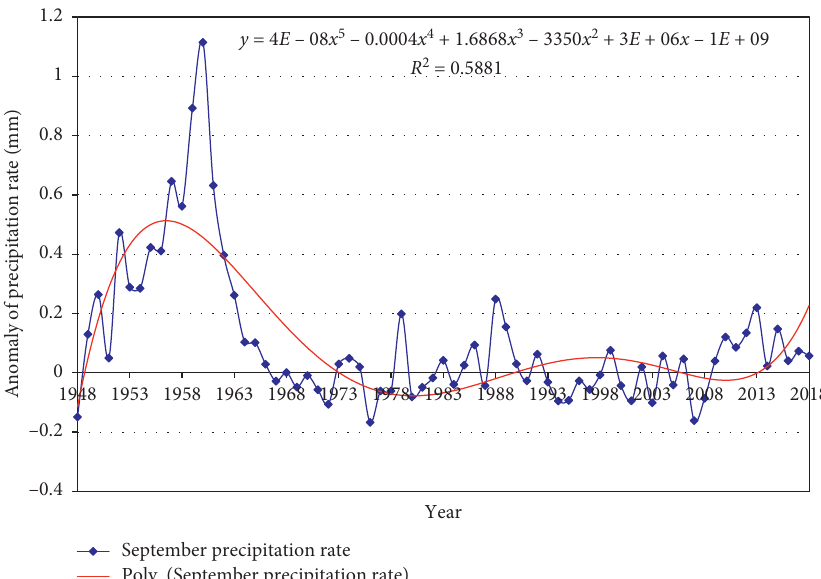
Figure 2: Time series of PR anomaly (mm/day) and its polynomial trend over the Arabian Peninsula, including SA in the month of September throughout the period (1948–2018).